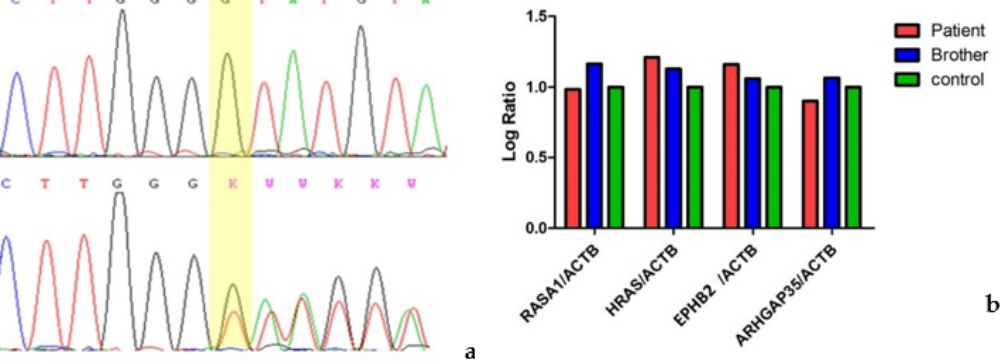
Figure 2. Electropherogram–affected brother below, unaffected sister above ( a ); Performing Real Time PCR, we evaluated the expression levels of RASA1 and of other genes directly regulated in pathways in which RASA1 is involved ( HRAS , EPHB2 , ARHGAP35 ), that showed an overlapping gene expression (including RASA1 gene) in proband, affected sibling and three independent controls ( b